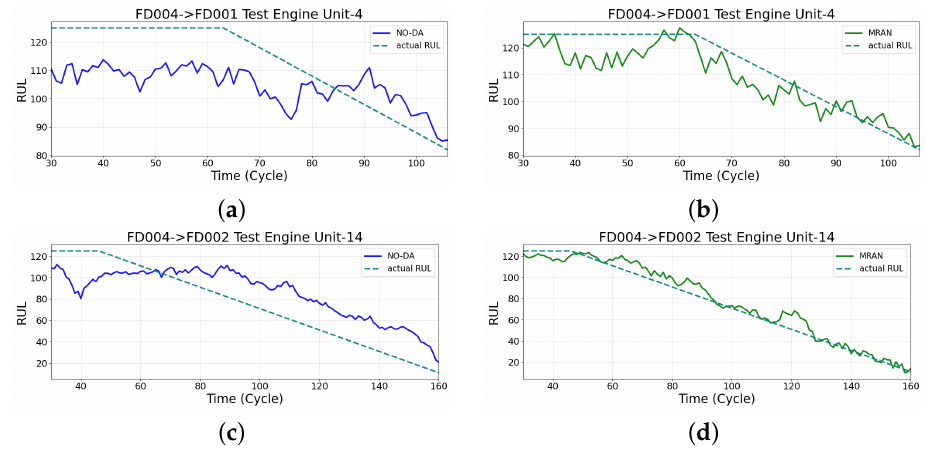
Figure 13. The source domain is FD004, and ( a ) is the prediction result of FD001 without domain adaptation. ( b ) FD001 prediction result after domain adaptation. ( c ) Prediction results of FD002 without domain adaptation. ( d ) FD002 prediction result after domain